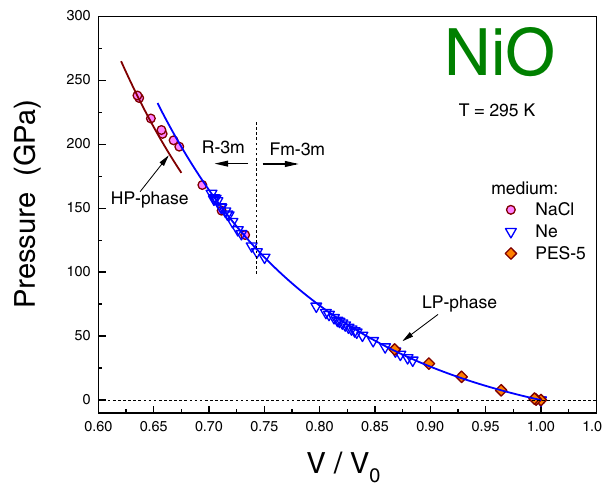
Fig. 3 The experimental pressure-volume dependence in NiO at hydrostatic and quasi-hydrostatic conditions up to 238 GPa. The fi gure combines values of relative volume change V/V 0 obtained from different high-pressure experiments. The diamonds correspond to run1, triangles correspond to run2 and run3, and circles correspond to run4. As pressure increased in the range of 208-238 GPa (run4), the onset of the iso- structural transition was observed with a volume drop about 2.65%. The Birch-Murnaghan equation of state was fi t to current experimental data, and its parameters were found are equal to B 0 = 192 ± 7 GPa, B ’ = 4.8 ± 0.1 for low-pressure phase (LP) below ~208 GPa (in blue). For high-pressure phase (HP) we used fi t of nonhydrostatic experimental data for modi fi ed Birch-Murnaghan equation of state (Supplementary Note 5). The solid line — calculated Birch-Murnaghan equations of state fi t very well all sets of experimental points